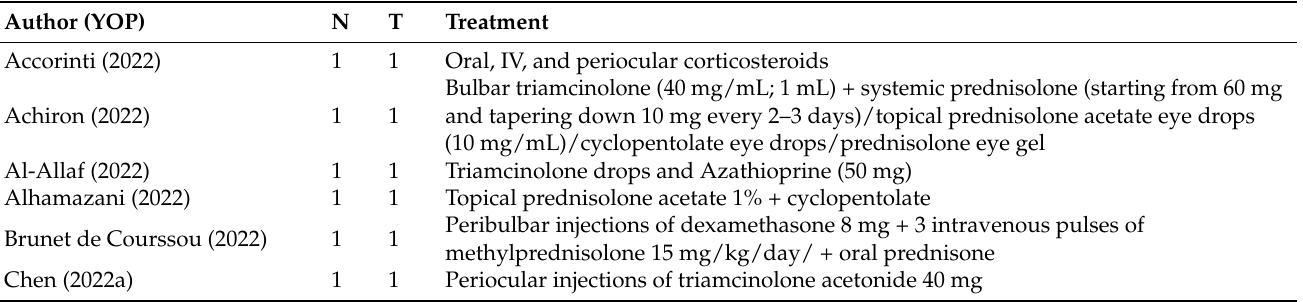
Table A2. The management strategy of COVID-19 vaccine-associated uveitis reported in the